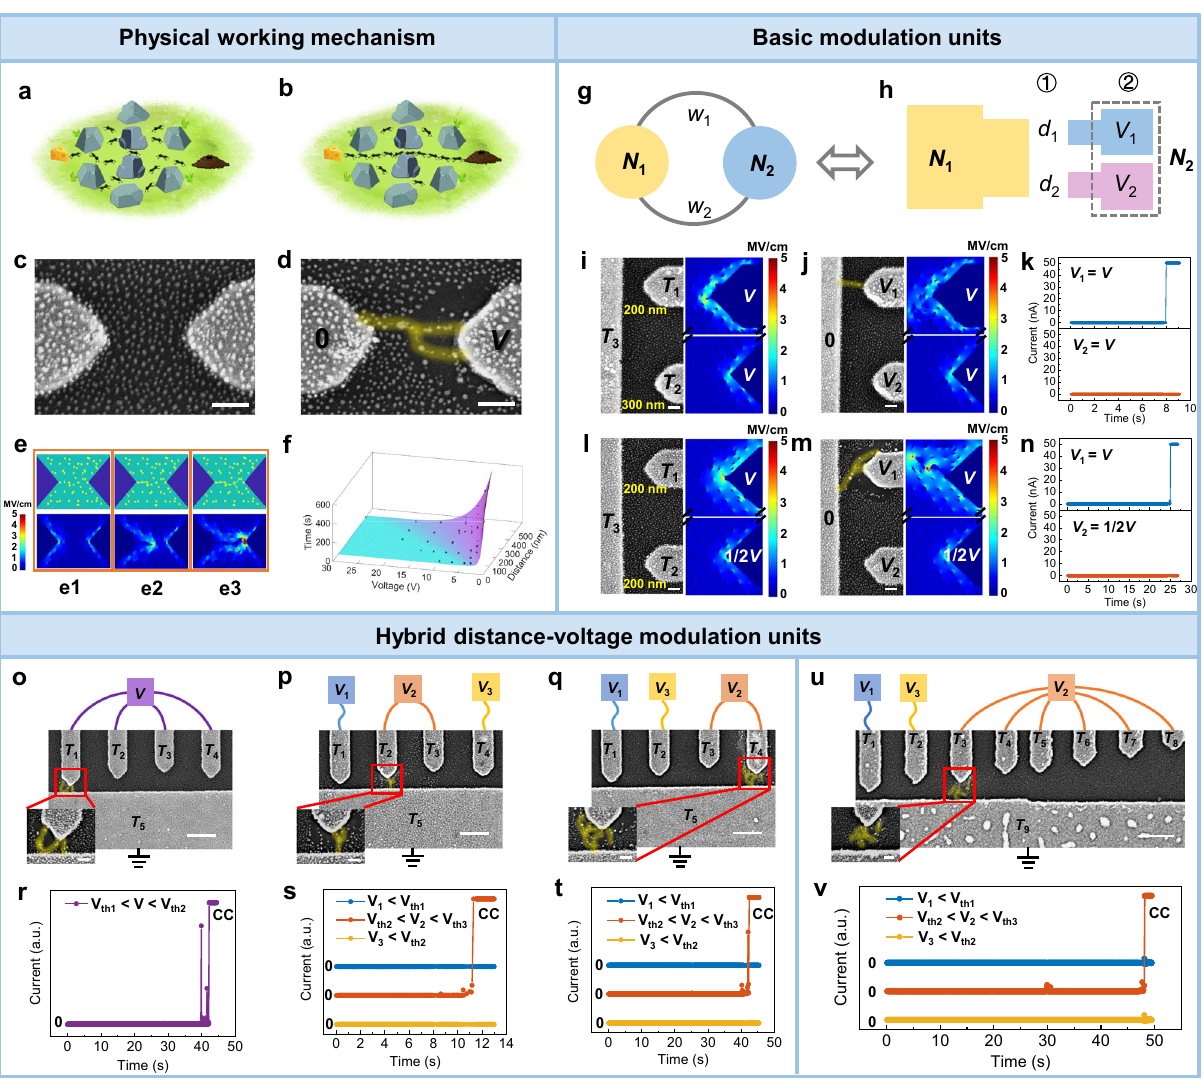
Fig. 1 | Physical operation principle and construction of modulation units. Schematicdiagram of the ant distributionin a , the earlyforaging periodand b ,the later foraging period. The originally randomly distributed ants fi nally converge to the shortest path to transport food. SEM image of the two-terminal device with ~200nmgap( c ), and afterswitching ( d ). V =25V.Scalebar:100nm. e MonteCarlo simulationoftheAgatom/clusterevolving(upper)andcorrespondingelectric fi eld distributions (bottom). f Forming time as a function of gap distance and applied voltage. g Graph structure composed of two nodes connected by two edges. h Schematic diagram of device structure and mapping schemes corresponding to ( g ). i SEM image (left) and initial electric fi eld distribution (right) of distance modulation unit. j Corresponding state after switching. Scale bar: 100nm. k Time- dependent current measurement from T 1 (blue) and T 2 (orange). V =10V. l SEM image (left) and initial electric fi eld distribution (right) of voltage modulation unit.